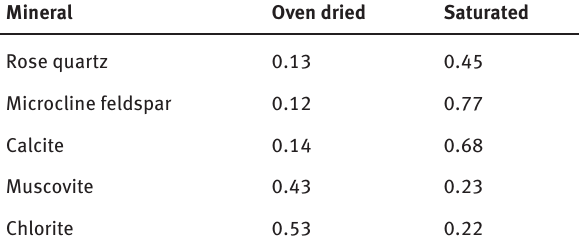
Table 1: Static friction coefficient of minerals under different : Rate-strengthening frictional strength of a single-asperity contact between calcite and an Figure 2 humidity conditions (data from Horn and Deere AFM tip in a 100 mM CaCl solution (after Diao and Espinosa-Marzal 2018) 2